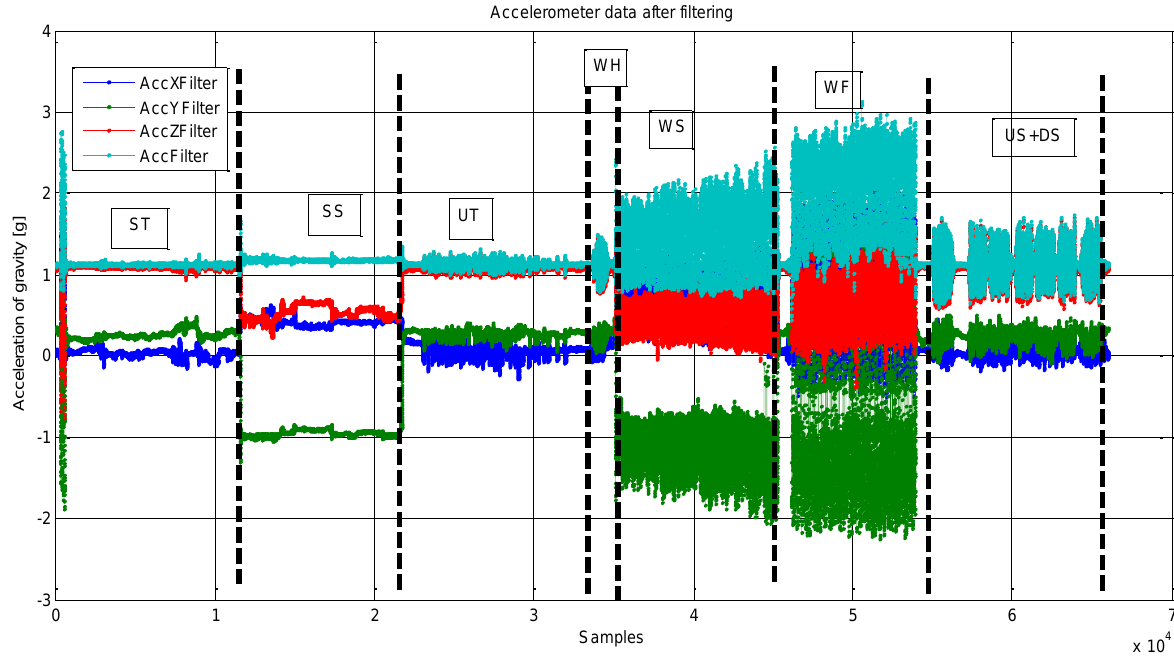
Figure 5. Accelerometer